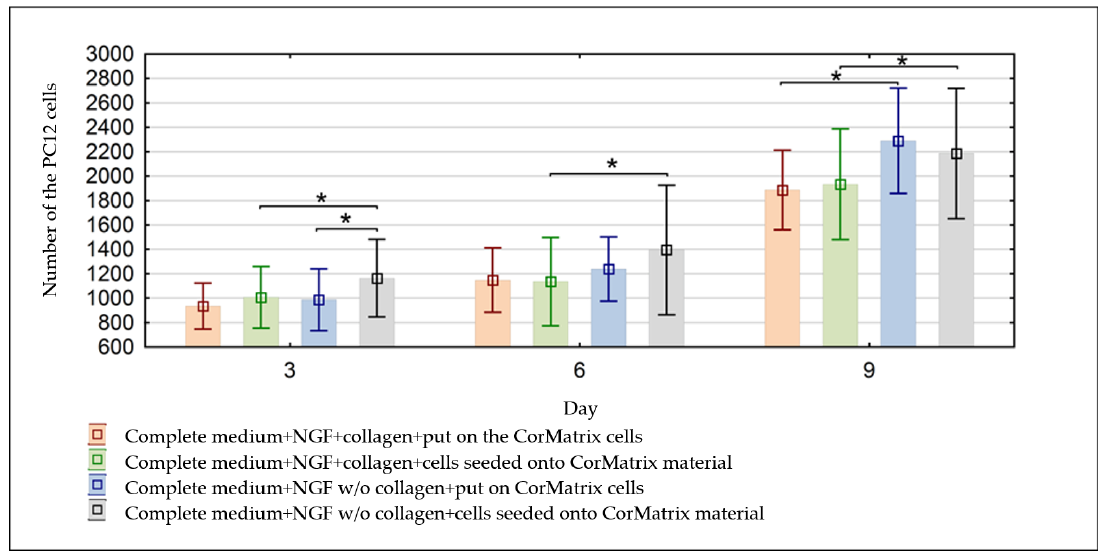
Figure 4. The average number of cells in the field of vision on the microphotographs of CorMatrix material; * p < 0.05— significant difference in number of cells.